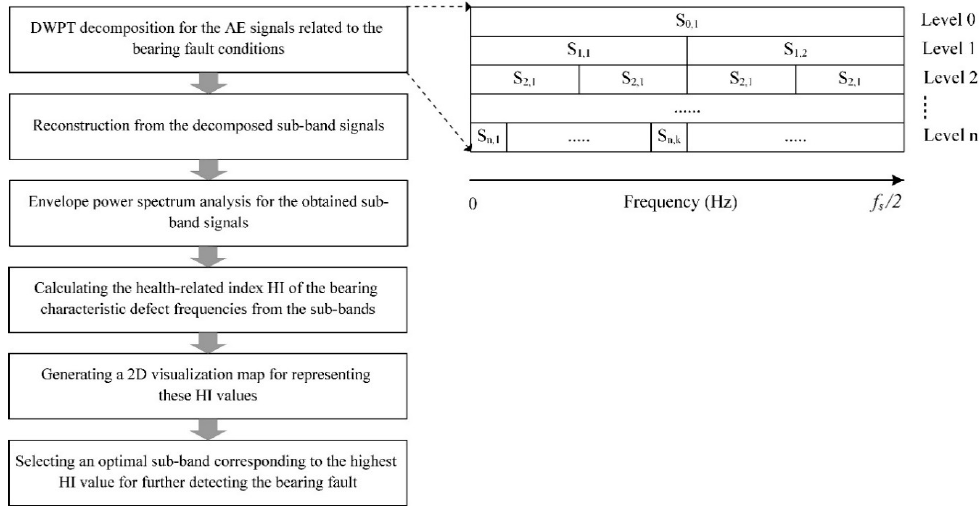
Figure 3. An analysis process of the sub-band signals based on EPS and DWPT decomposition.